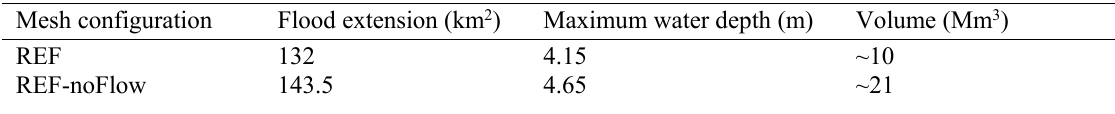
Table 1 Results of 2D simulations performed with different model schematizations. Mesh